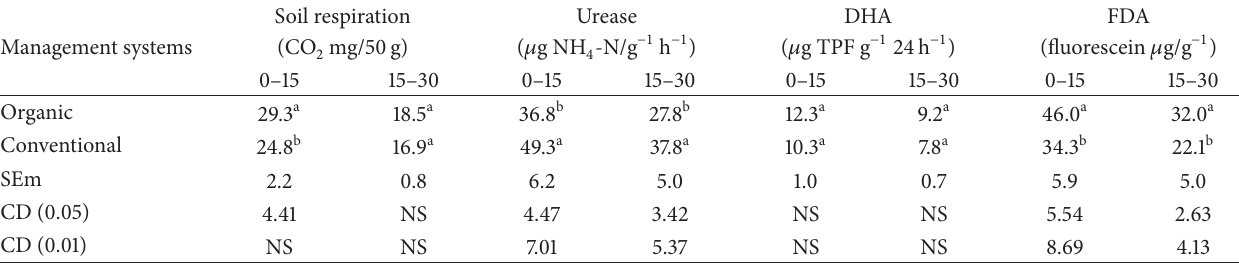
Table 2: Organic and conventional method of coffee farming on selected soil biological properties. Soil